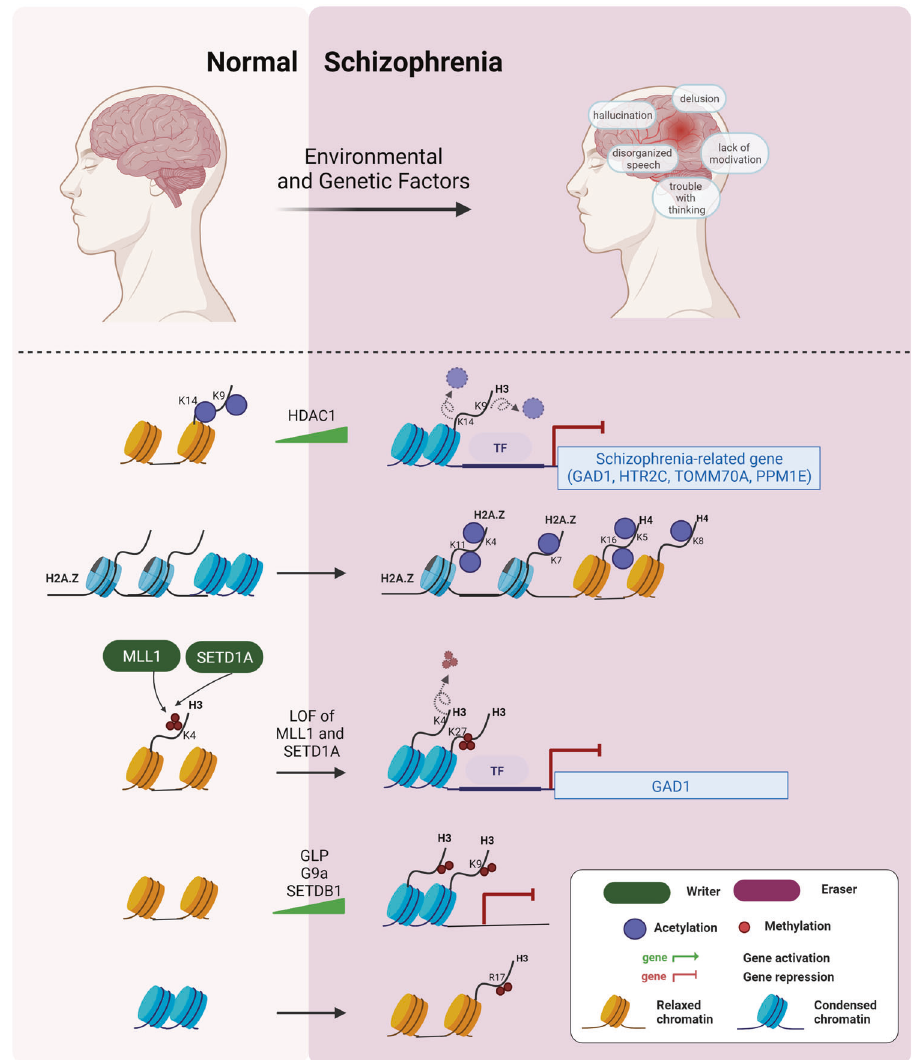
Fig. 8 Dysregulation of histone-modifying enzymes and histone modi fi cations in schizophrenia (SZ). Increase of repressive histone marks (e.g, H3 deacetylation by HDAC1, decrease of H3K4me3 by loss of MLL1 or SETD1A mutation, and increase of H3K27me3) suppresses GAD1 expression. Increase in H2A.Z acetylation, H3K9me3, and H3R17me is observed in